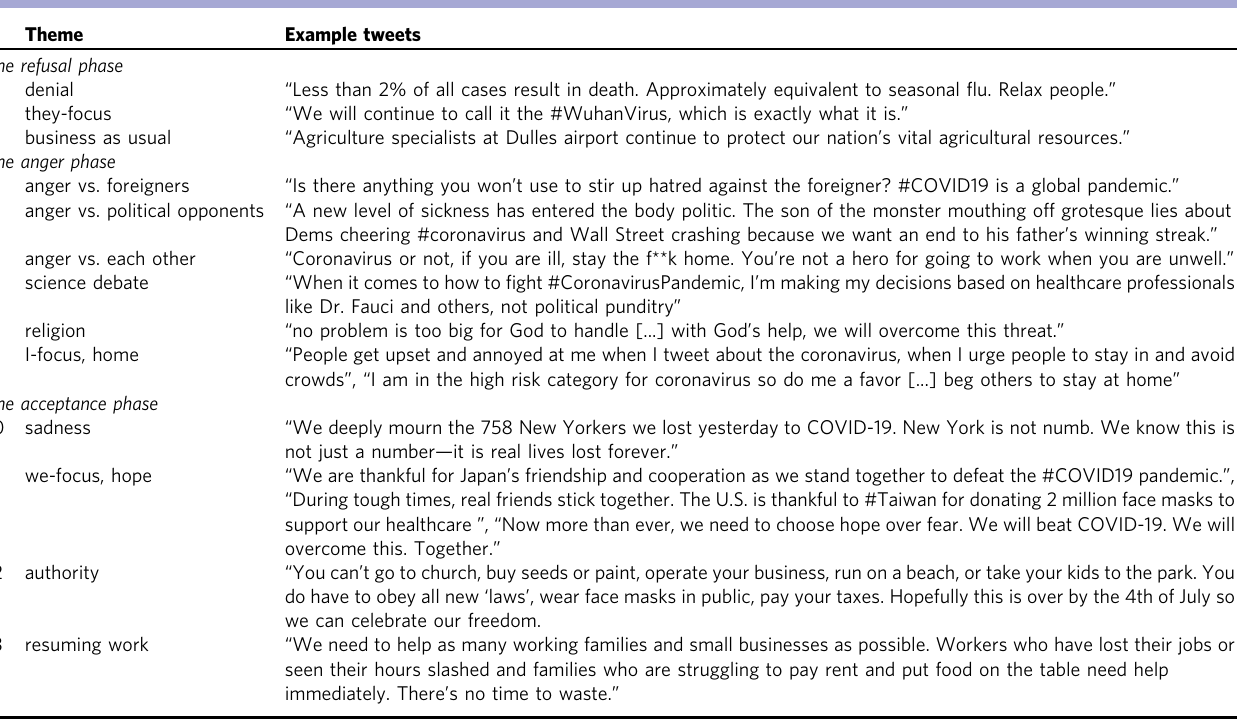
Table 2 Recurring themes in the three phases, found by the means of thematic analysis of tweets.